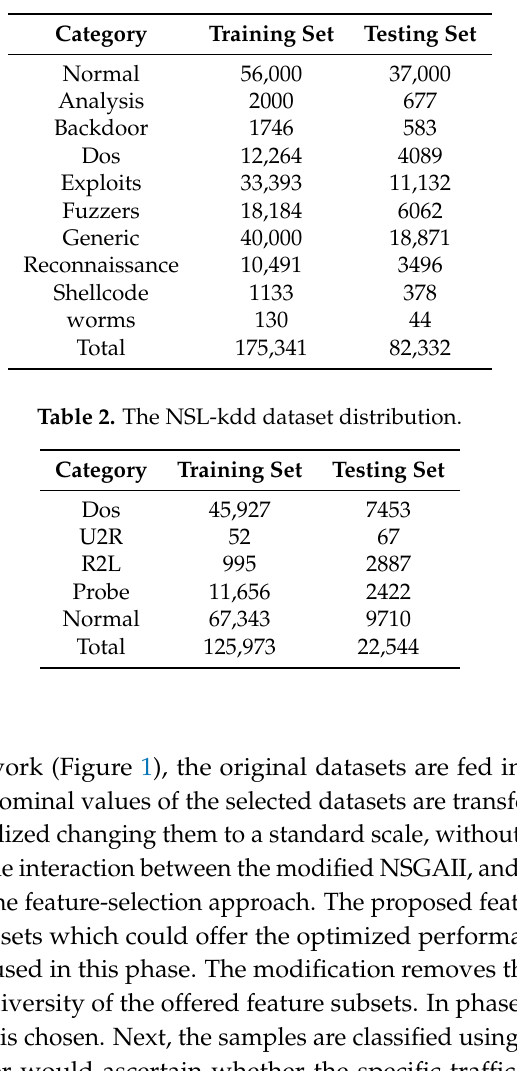
Table 1. The UNSW-NB15 datasset distribution.